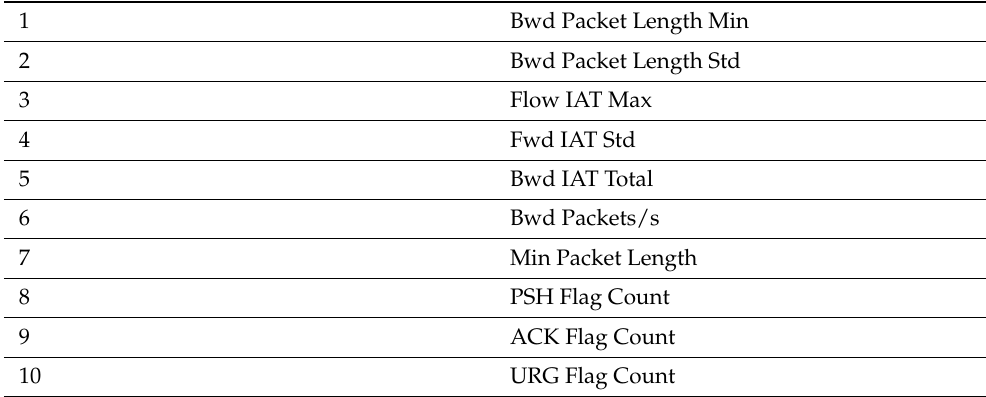
Table 3. Top 10 features in dataset.